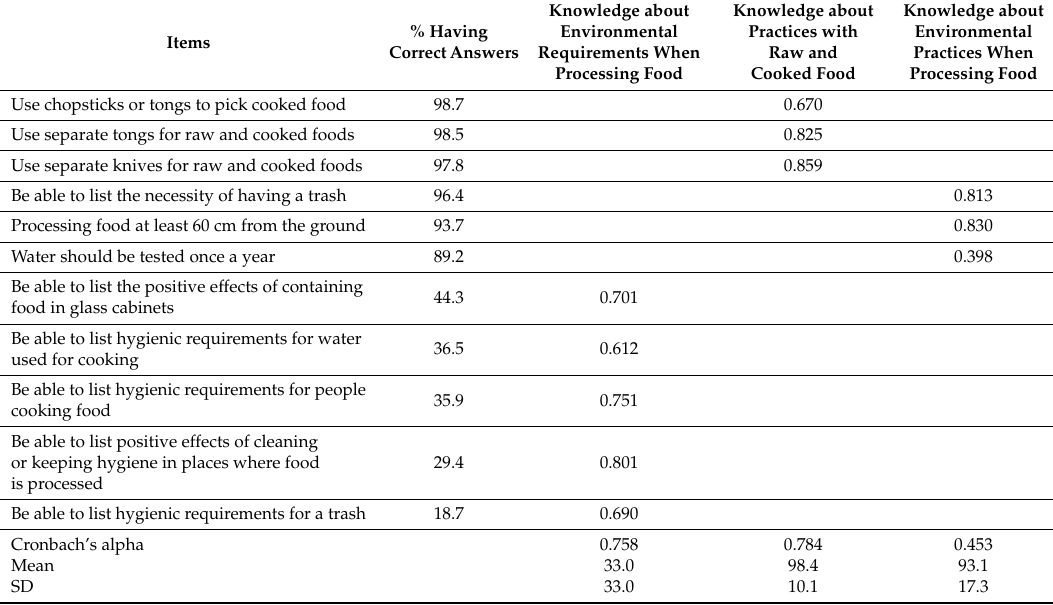
Table 2. Knowledge about food hygiene and safety among customers in food